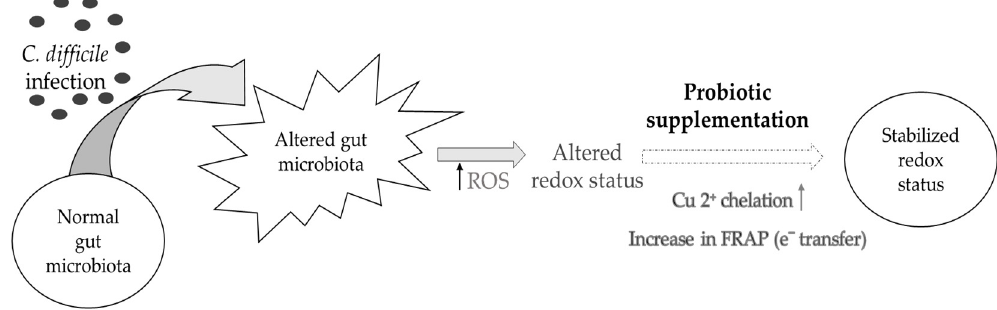
Table 1. Spearman’s correlation ( ρ ) of normal fecal samples.